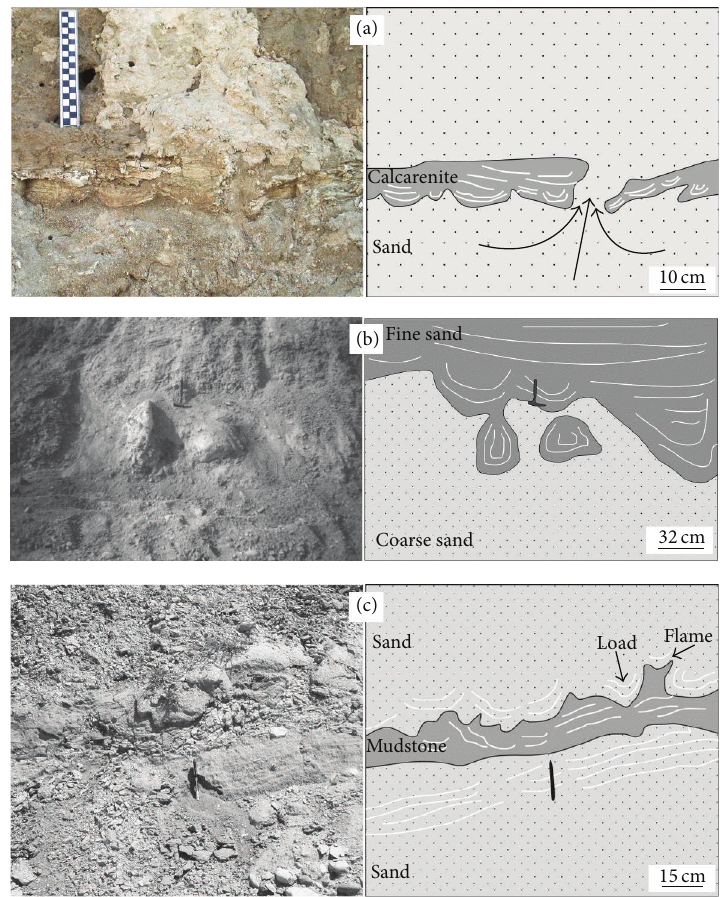
Figure 3: (a) Widely observed load structure seen in the study area and mainly formed in calcarenite and sands (37.770 N, 29.146 E). (b) This structure which is formed in fine and coarse-grained sand and named by Alfaro et al. [40] similar to drop structures. About 40 cm of material sunk into coarse-grained sand with detachment occurring in a later deformation phase (37.795 N, 29.154 E). (c) Load and flame structures observed in 15cm thick mudstones in sand (37.773 N, 29.157